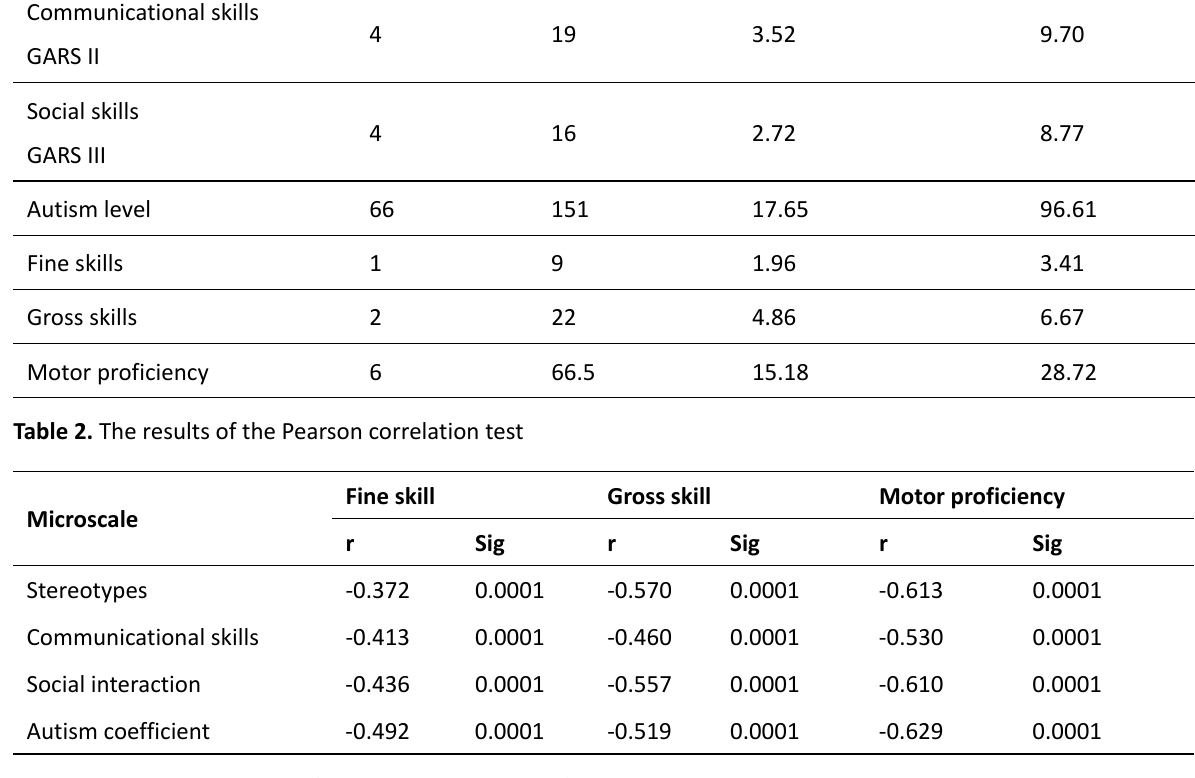
Table 3. Regression analysis of predicting autism level from motor skills Model